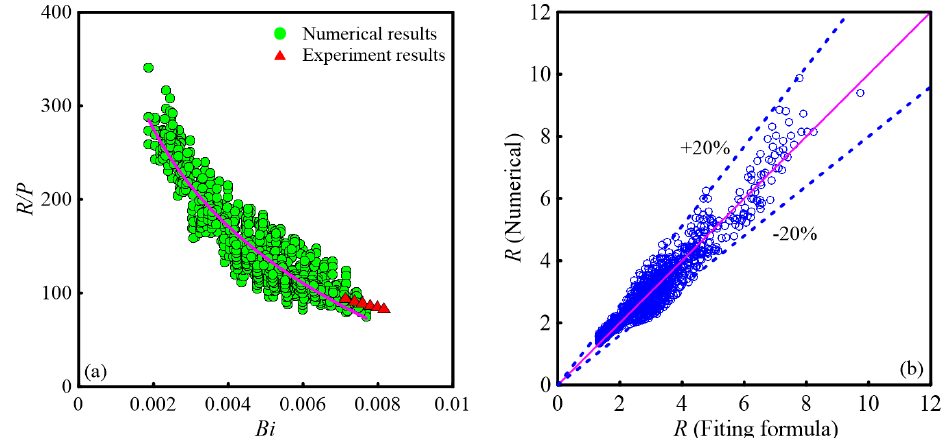
Fig. 9. Relationship between R/P and